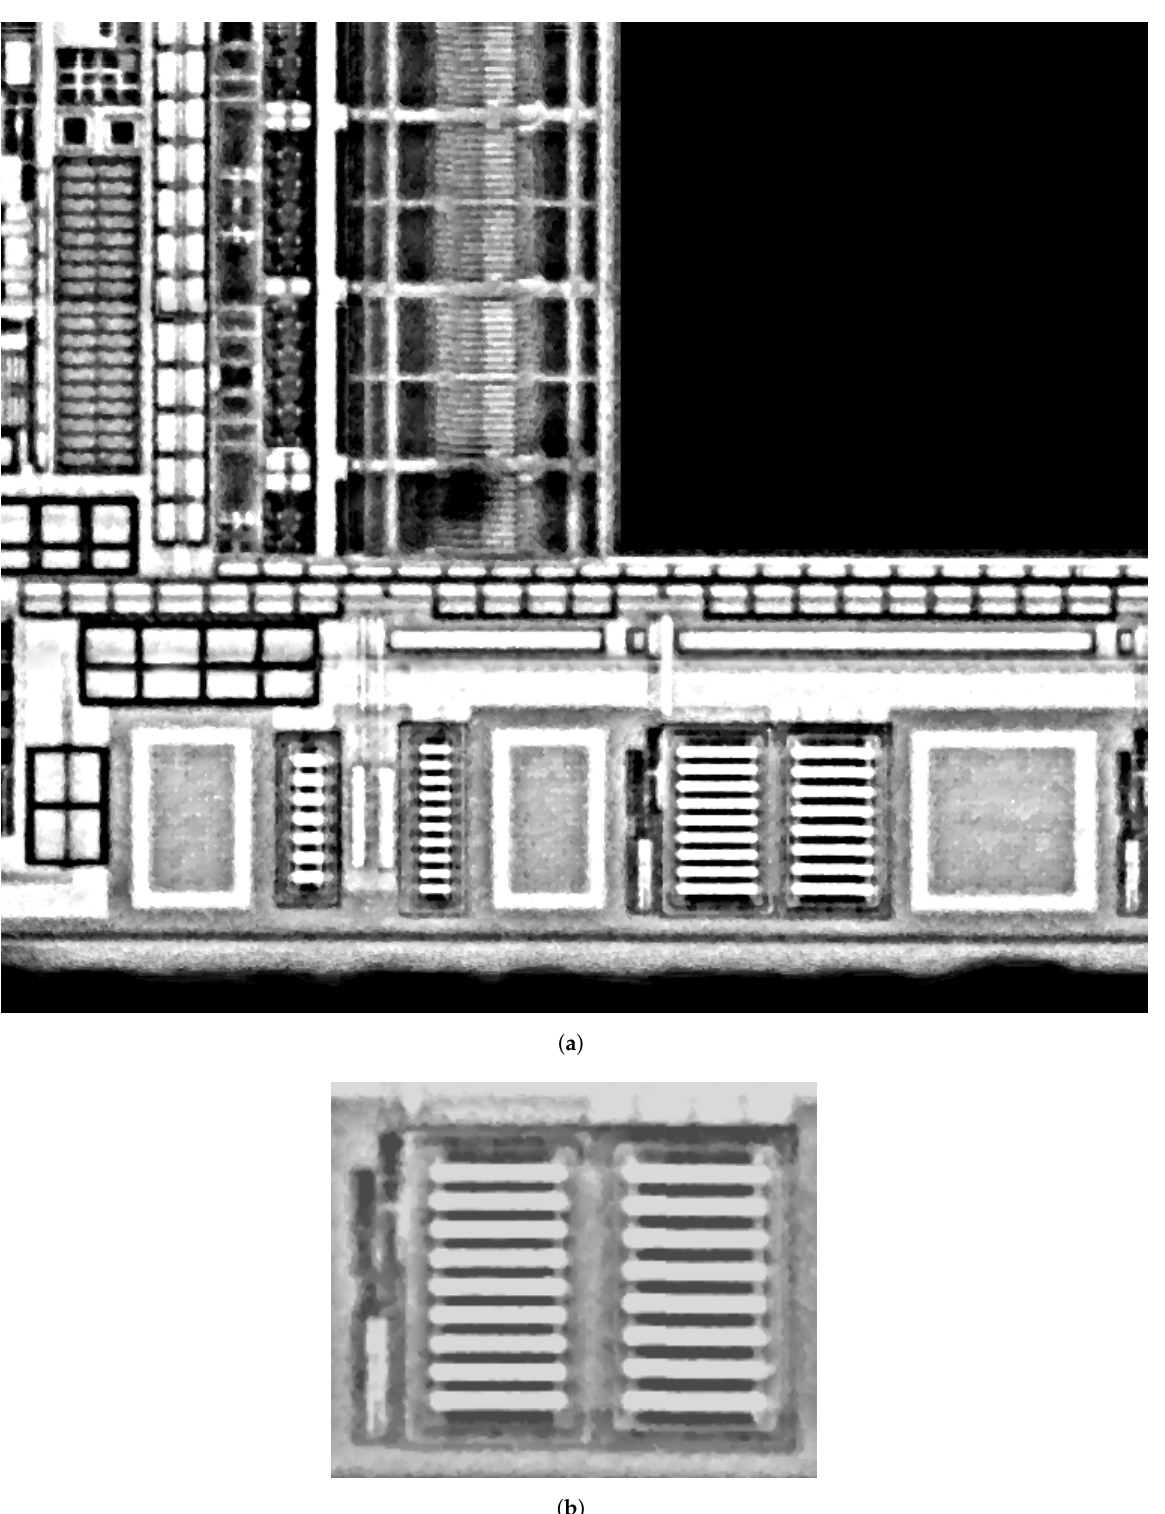
Figure 10. Image acquisition under a 20 × optical magnifier of ( a ) a partial view of an integrated circuit (target) ( b ) an electronic structure of interest